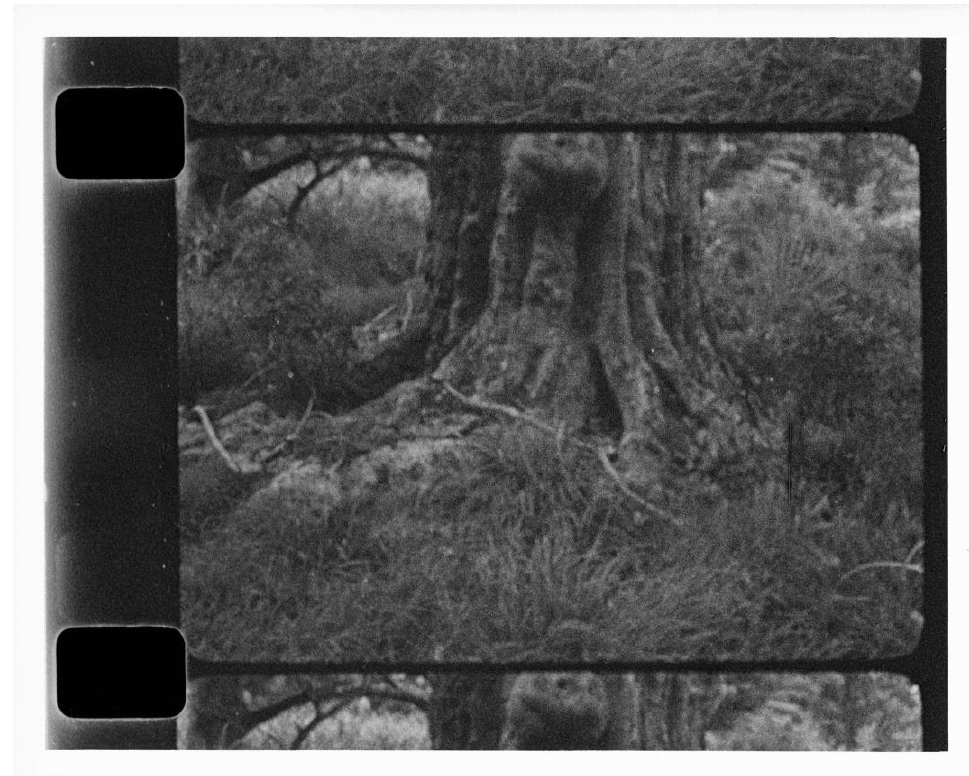
Figure 1. Nova Paul, Rākau , 2022, 16mm film print.